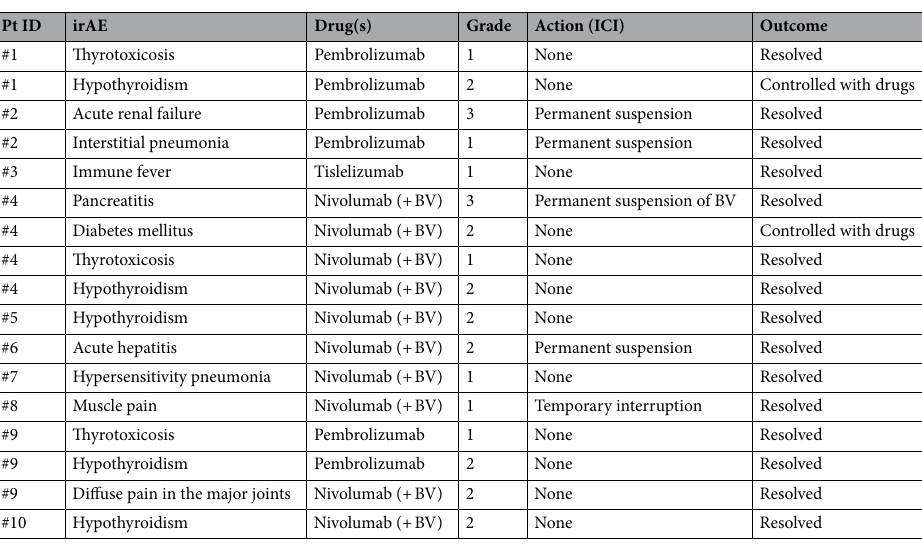
Table 1. Immune-related adverse events occurred during treatment with immune-checkpoint inhibitors. BV brentuximab vedotin, ICI immune checkpoint inhibitor, irAE immune-related adverse event, pt